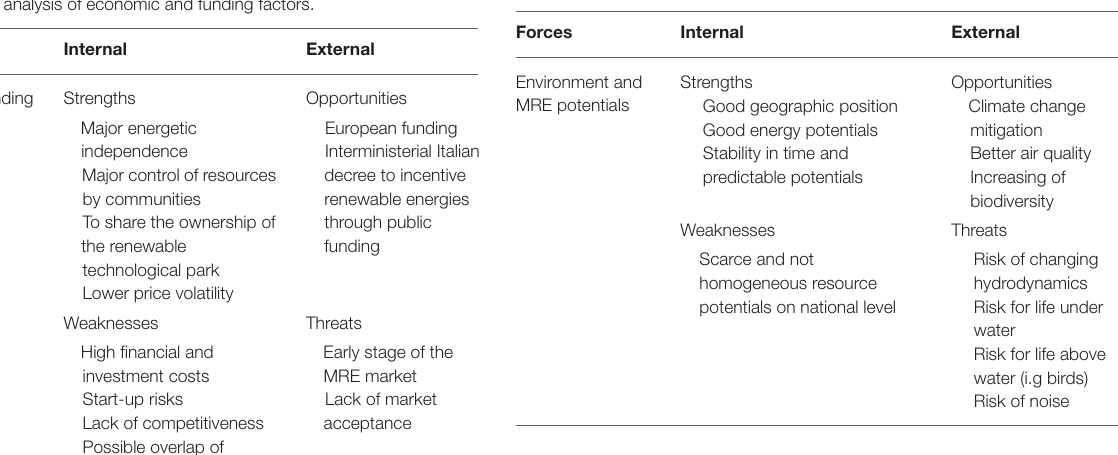
TABLE 5 | SWOT analysis of environmental and MRE potential